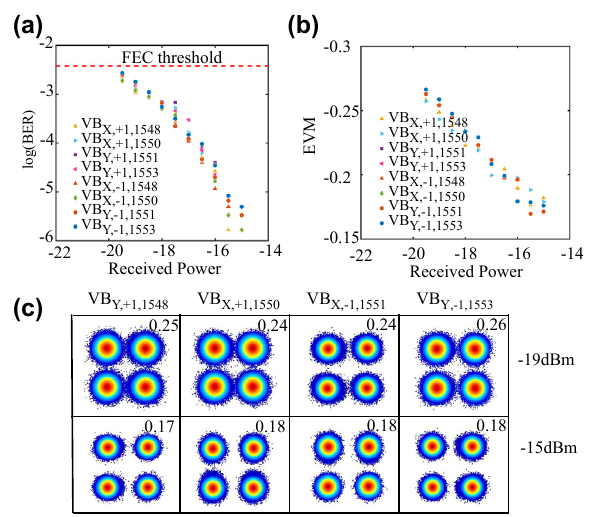
Figure 4: Results for multiplexing communication. (a) BER curve and (b) EVM curve. FEC, forward error correction. (c) Constellations of different channels for different optical power. The EVMs data of Constellations are marked in the upper right